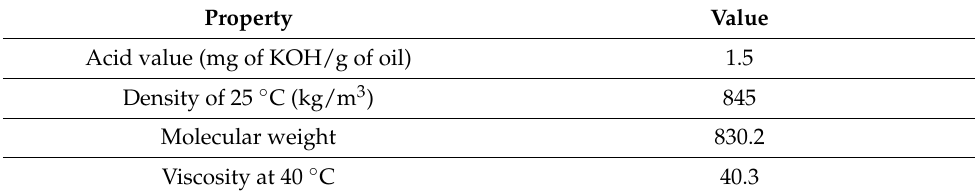
Table 3. Physicochemical properties of